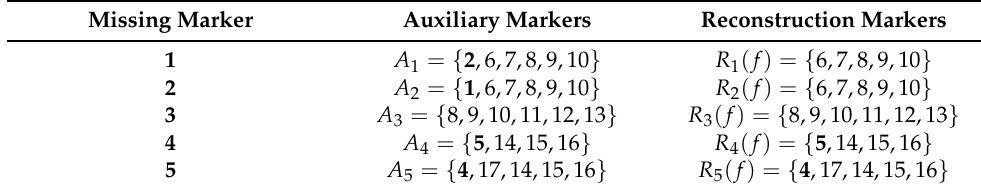
Table 1. Markers selected to assist the reconstruction of missing markers in a certain frame (example scenario). Missing markers are presented in bold to facilitate the analysis. Missing